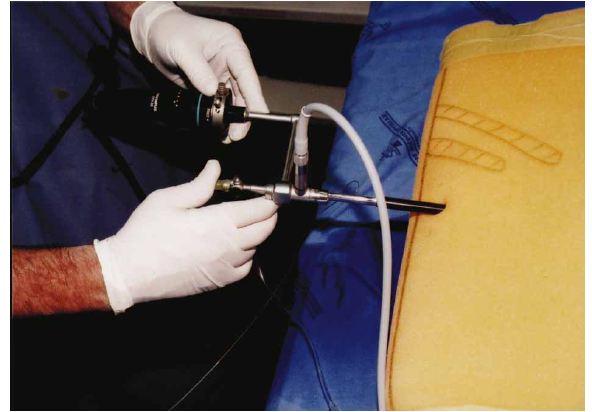
Figure 6 - Kidney examination after training and removal of perirenal fat. The site of intra-renal puncture can be